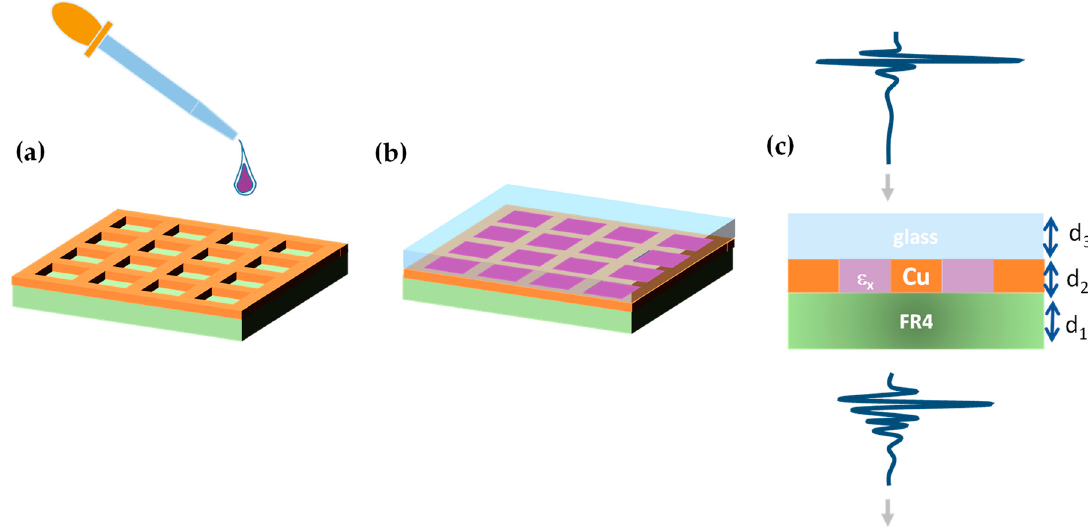
Figure 1. ( a ) and ( b ): sketch of the steps for the preparation of the capped metagrid (CMG) sample with analyte. ( c ): Measurement setup configuration and section view of the capped metasurface, where d 1 = 160 μ m, d 2 = 30 μ m, d 3 = 150 μ m.